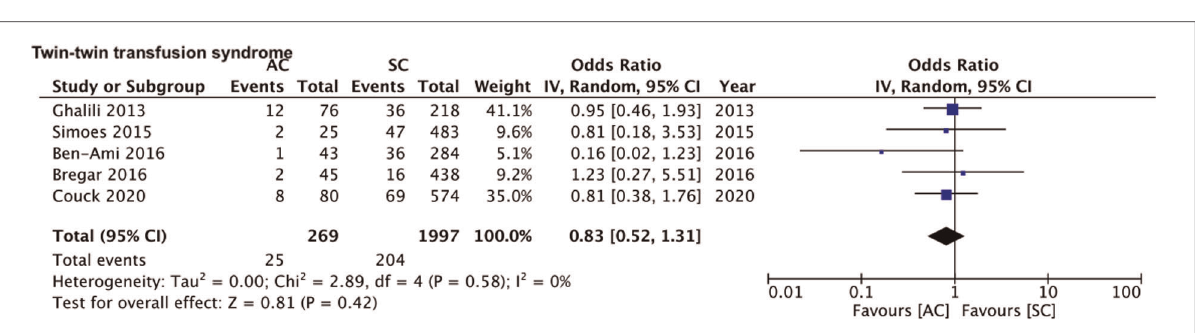
FIGURE 4 Meta-analysis of TTTS between assisted and spontaneously conceived monochorionic twin pregnancies.